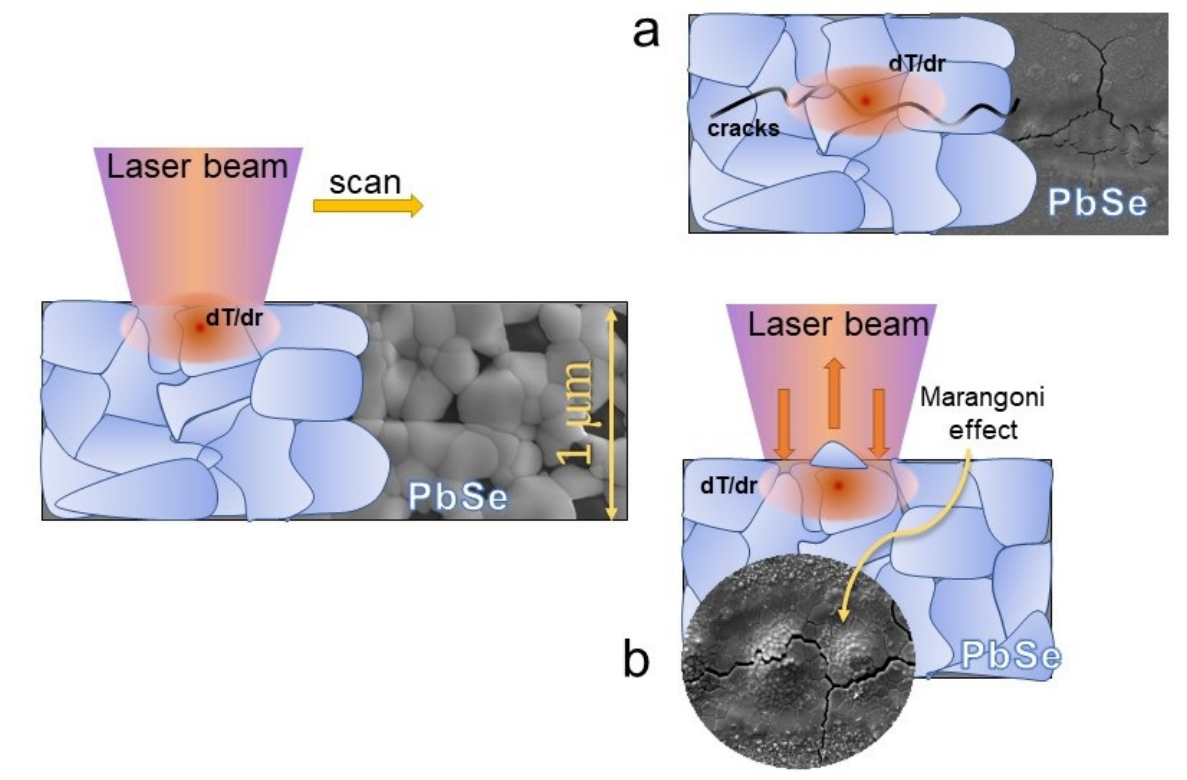
Figure 9. Mechanism of defective centers occurrence in the film modification area: ( a ) crack formation, ( b ) Marangoni effect.